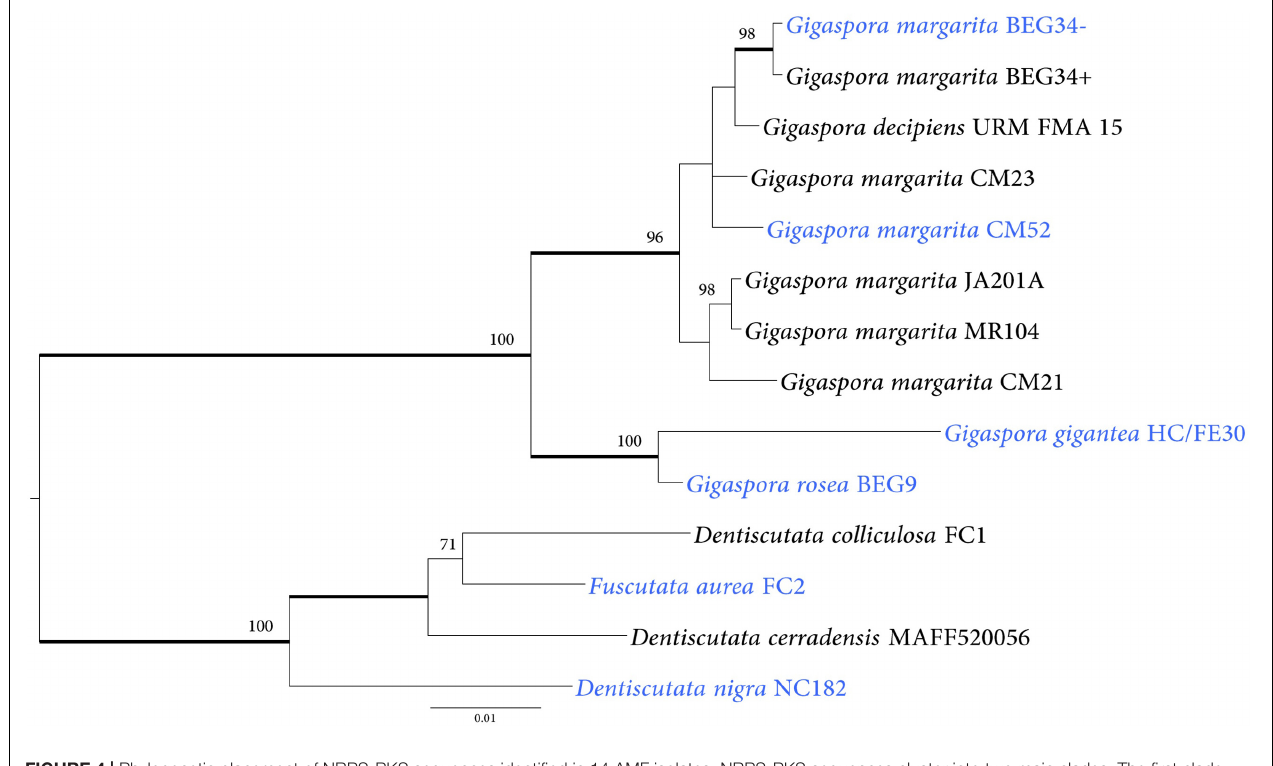
FIGURE 4 | Phylogenetic placement of NRPS-PKS sequences identified in 14 AMF isolates. NRPS-PKS sequences cluster into two main clades. The first clade encompasses sequences from species in the Gigasporaceae family; the second clade includes sequences from taxa that belong to the Dentiscutataceae family. The tree shows the topology obtained with the Bayesian method; branches with Bayesian posterior probabilities ≥ 0.95 are thickened and ML bootstrap support values ≥ 70 are shown. The isolates shown in blue color do not host Ca Gg. Gigaspora margarita BEG34- and G. margarita BEG34+ are isogenic, but the first was artificially cured from its endobacterium (Lumini et al.,